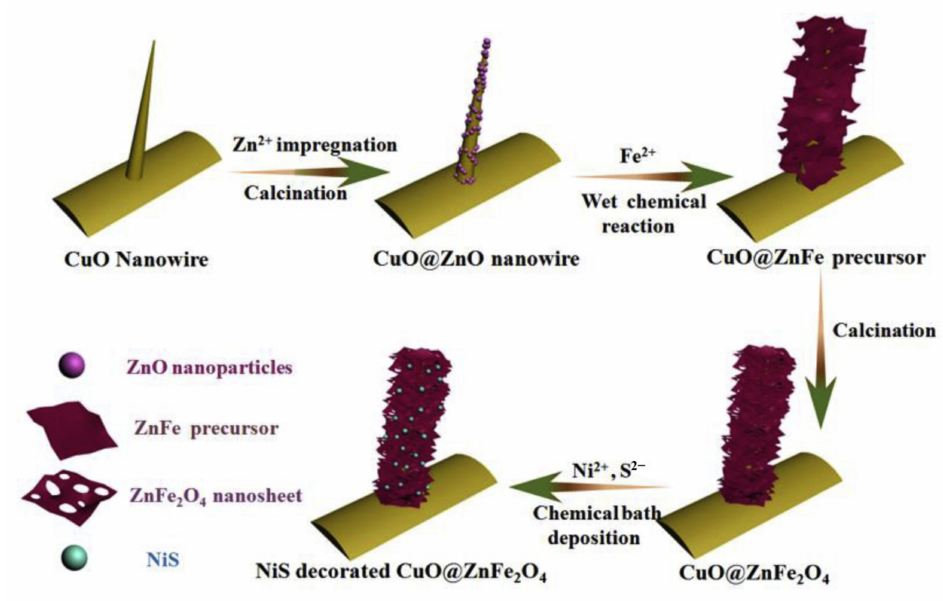
Figure 18. A schematic representation of the formation process of the CuO@ZnFe 2 O 4 core/shell nanoarrays decorated with NiS quantum dots [114] (reprinted with permission from [114] Chen et al.,